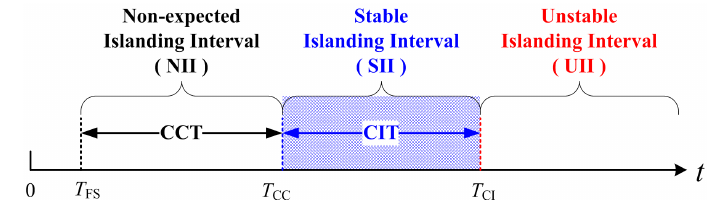
Figure 1. Critical islanding time (CIT) and stable islanding interval for controlled islanding. CCT: Critical clearing time.